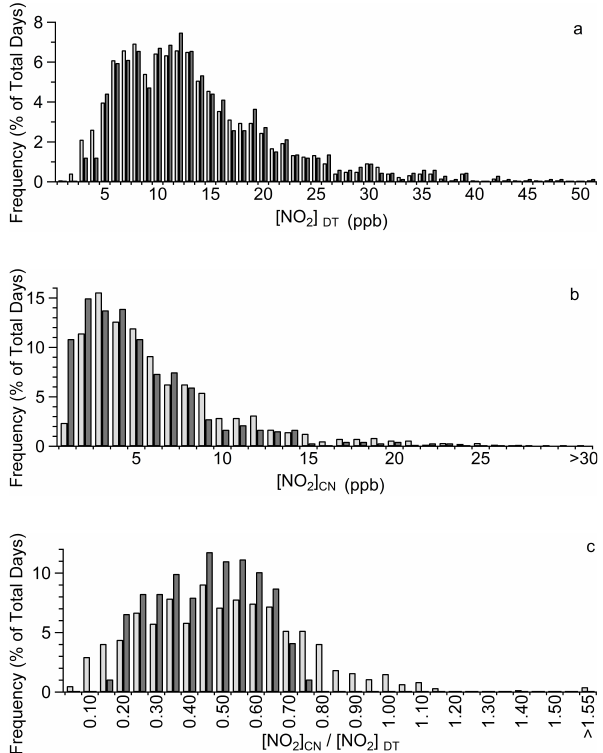
Fig. 2. (a) Frequency distribution of NO 2 DT volume mixing ratio during OMI overpass time. Light-grey bars refer to data meeting criteria 1–4 in Table 3 (Total Days=1181) and dark-grey bars refer to data meeting all criteria in Table 3 (Total Days=654). (b) Same as (a) but for NO 2 CN. (c) Same as (a) but for ratio of [NO 2 ] CN to [NO 2 ] DT